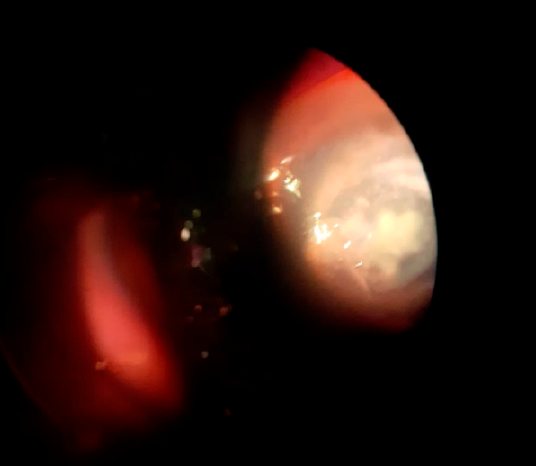
Figure 2. Slit-lamp examination of the right eye highlighting severe conjunctival hyperemia, infil- trated cornea, 6–7 mm central corneal abscess, and